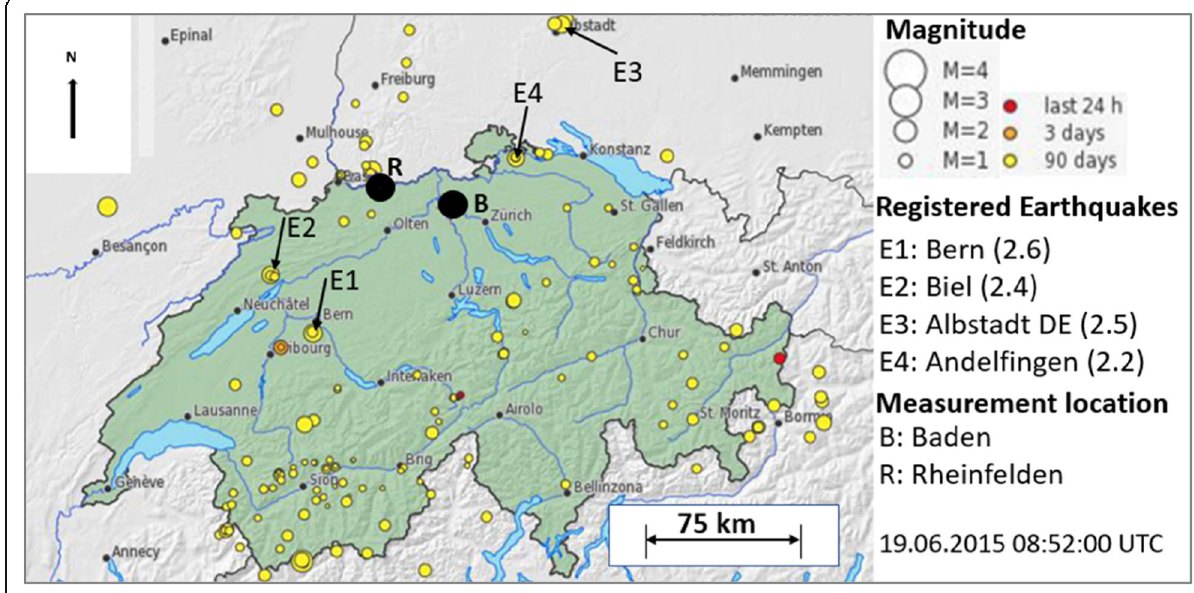
Fig. 6 Map of Switzerland with representation of all the earthquakes, which were registered within a time span of 90 days before the fluorescence monitoring was stopped are highlighted in the map of Switzerland by yellow dots. The size of the circles corresponds to the magnitude of the earthquakes according to the legend on the right side. The location of the earthquakes from Table 1 are highlighted with the blackish arrows. The measurement locations Baden (B) and Rheinfelden (R) are indicated by the bolt blackish dots (modified after